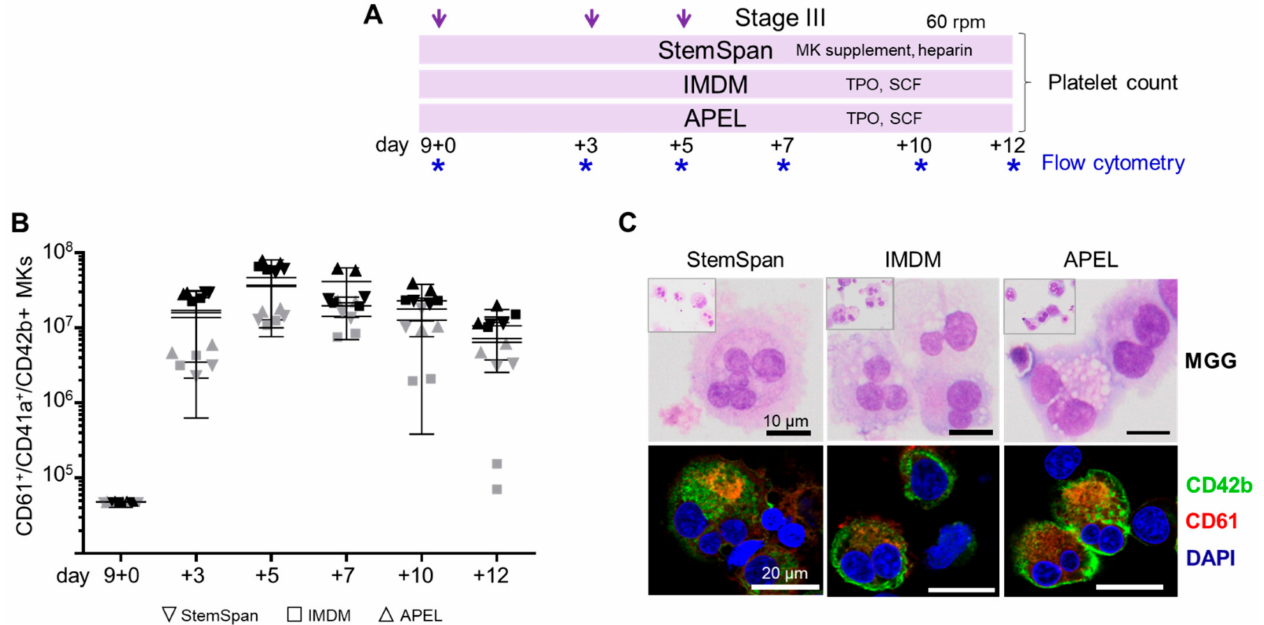
Figure 2. Expansion and maturation of hiPSC-derived megakaryocytes (MKs) in different media conditions. ( A ) Exper- imental outline using the improved induction conditions. Megakaryocyte progenitors (MKPs) derived from stage II at days 9, 12, and 14 (purple arrows) were harvested and matured into MKs in stage III for up to 12 additional days in three different media (StemSpan, IMDM or APEL), supplemented as indicated. From day 9 + 10 on, MKs were cultured under dynamic conditions at 60 rpm. Cells were harvested, counted, and analyzed by flow cytometry (platelet counts are shown in Figure 3B,C). ( B ) The total amount of CD61 + /CD41a + /CD42b + maturing MKs revealed no significant difference after culture in the three different media (StemSpan, down pointing triangle; IMDM, squares; APEL, upward pointing triangles; three different mean value lines representing the three media; symbol color depicts the two independent hiPSC clones UCB144-CT2-C, grey and BIHi001-A, black; n = 4, p > 0.05; two-way ANOVA, multiple comparisons). ( C ) MKs showed various maturation stages, indicated by two or more nuclei (deep purple), independent of media conditions (May–Grünwald Giemsa stain, MGG; top row, lower magnification inserts). Characteristic MK immunophenotype CD42b (green), CD61 (red); nuclear DAPI stain (blue; lower row). Representative pictures of two replicates of clone BIHi001-A are shown after harvest on day 9 + 7 (stage III) and stained as